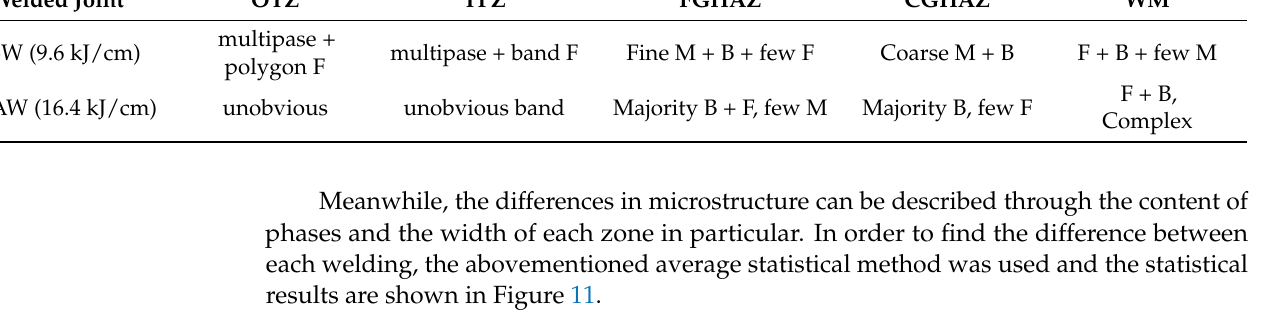
Figure 10. Microstructure in HAZ of SMAW joint ( a ) Macro-photo in HAZ ( b ) Chain-distribution of carbides in HAZ ( c ) OTZ ( d ) OTZ close to BM. F:ferrite; M:martensite; B: bainite